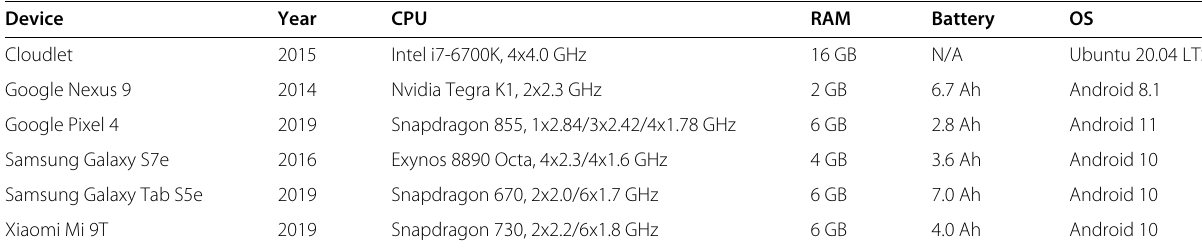
Table 3 Device characteristics